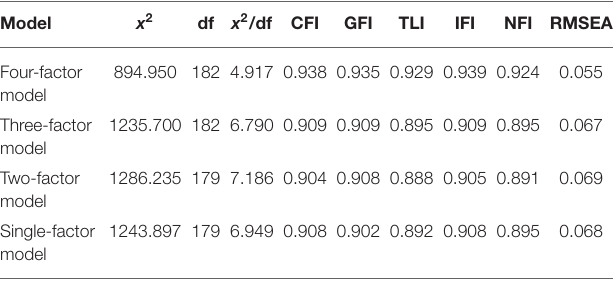
TABLE 3 | Means, SD, and intercorrelations (junior middle school boys and